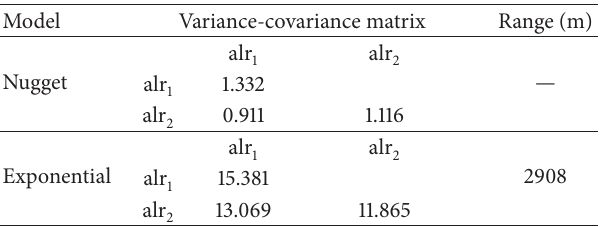
Table 4: Parameters for the fitted linear model of coregionalization for alr.